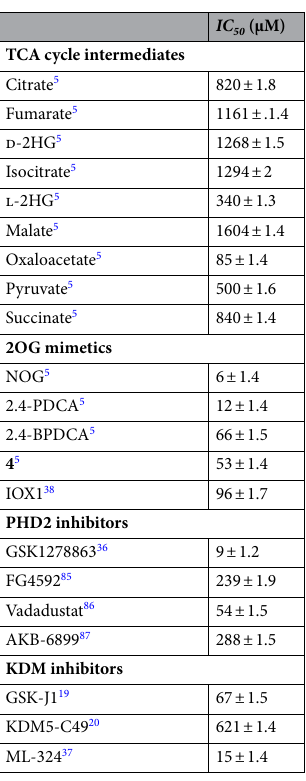
Table 1. IC 50 values for JMJD5 FL inhibitors that likely bind in the 2OG cosubstrate pocket. A full-length JMJD5 construct (aa 1–416, JMJD5 FL ) was used in the inhibition assays. IC 50 values were determined using MALDI-TOF-based hydroxylation assays with 10 µM JMJD5 FL , 100 µM Fe(II), 400 µM ascorbate, 50